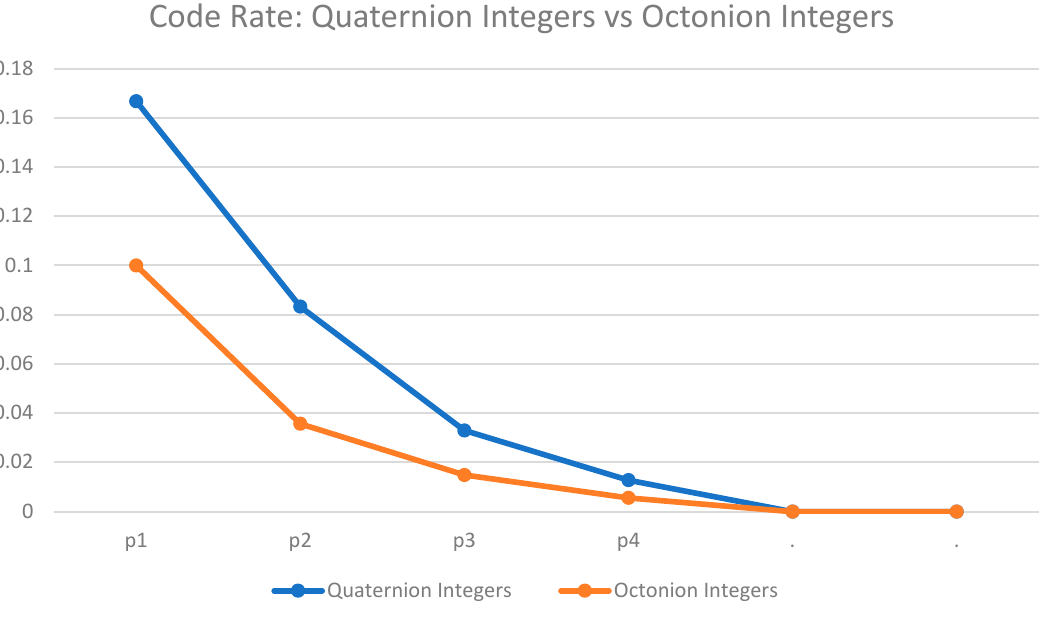
Figure 2. Quaternion integers Code rate vs. Octonion integers Code rate.